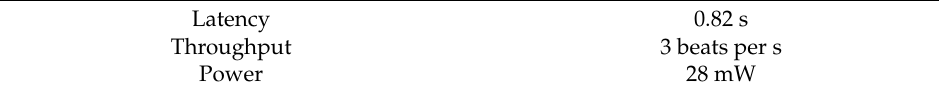
Table 2. FPGA implementation